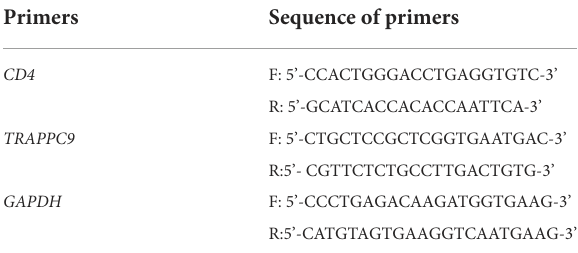
TABLE 1 Detail of PCR primers of qRT-PCR used in the